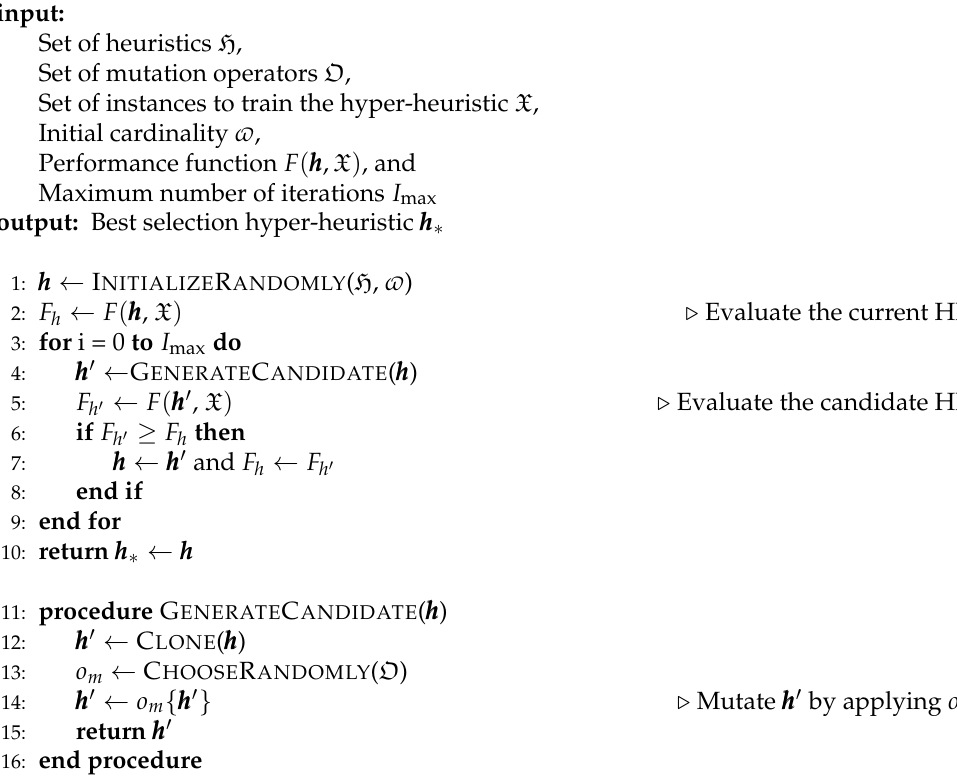
Pseudocode 1 Hyper-heuristic